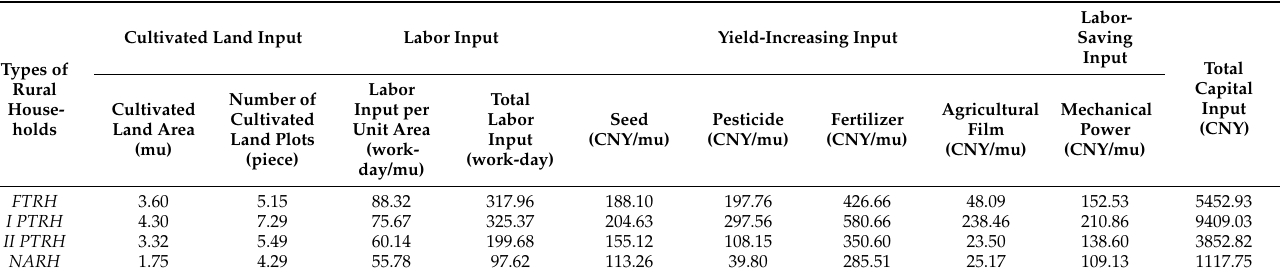
Table 4. Inputs of different types of rural households.